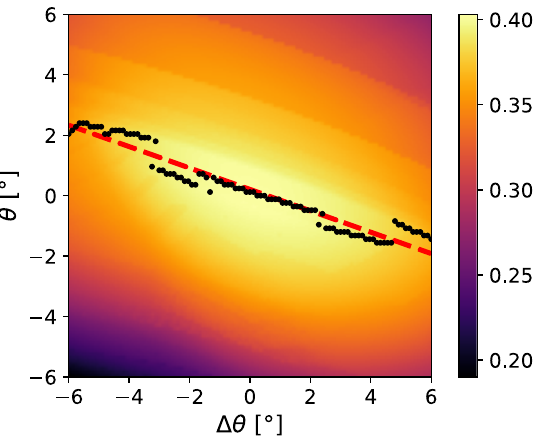
Figure 11. Maximum C P achievable for each degree of imbalance ∆ θ and collective pitch angle θ . Black dots: maximum C P for each ∆ θ . Red dashed line: linear interpolation.